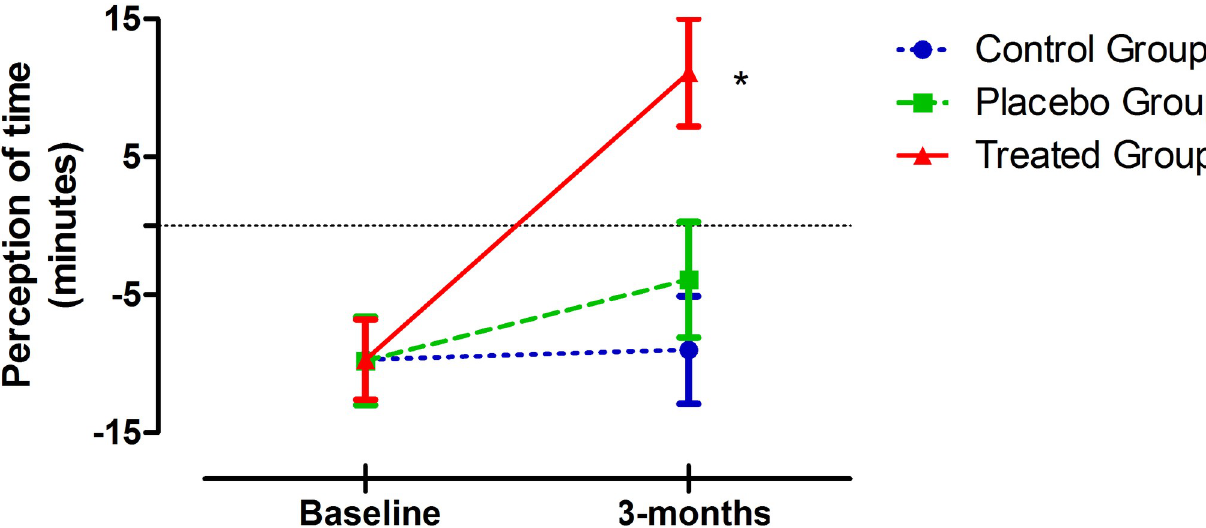
Fig 3. Change in perception of time. To analyze the perception of time, the apparent time value reported on the questionnaire was subtracted from the actual time value given (actual time—apparent time = perception of time). Positive value: perception of ACT shorter. Negative value: perception of ACT longer. Values above 0: participants felt they spent less time taking the ACT routine than the actual time they spent to taking it. Values below 0: participants felt they spent more time taking the ACT routine than the actual time they spent taking it. Differences were calculated at baseline and the final interviews. The data are presented as the mean ( ± SD). Wilcoxon test was performed to compare the differences between the baseline and final measures in each group. Changes: � p = 0.003 (Treated Group); p = 0.076 (Placebo Group); p = 0.857 (Control Group).